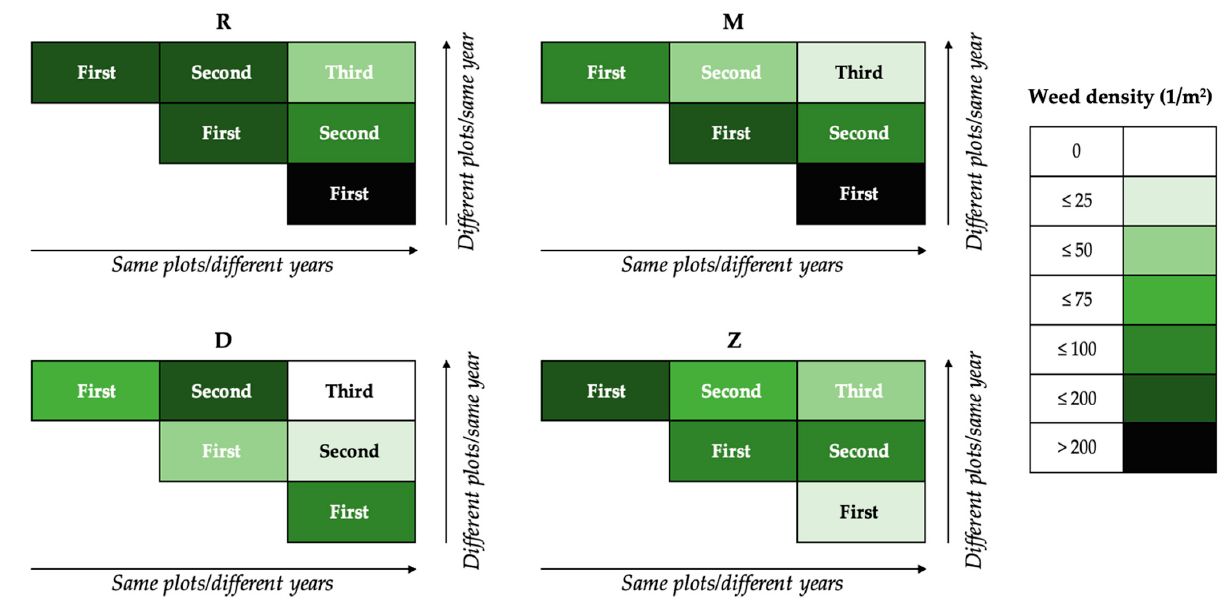
Figure 2. Weed density at the four experimental sites in two set-ups. Plots based on the chronological progression of the experiments are given in Table 2. The weed density classes are divided into intervals of 0 to ≤ 100, 101 to ≤ 200 and greater than 200, with the interval from 0 to ≤ 100 subdivided into 25 steps. The intensity of the colour increases with weed density class.